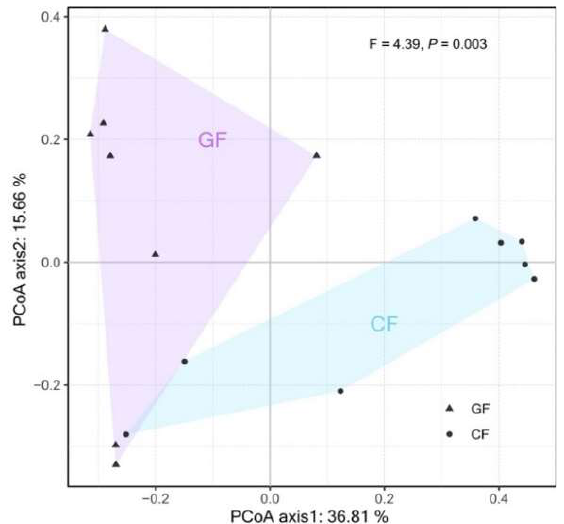
Figure 4. Principal coordinates analysis (PCoA) plot based on Bray–Curtis dissimilarity visualizing dissimilarities in the intestinal bacterial community of grass carp fed with ryegrass and a commercial diet.